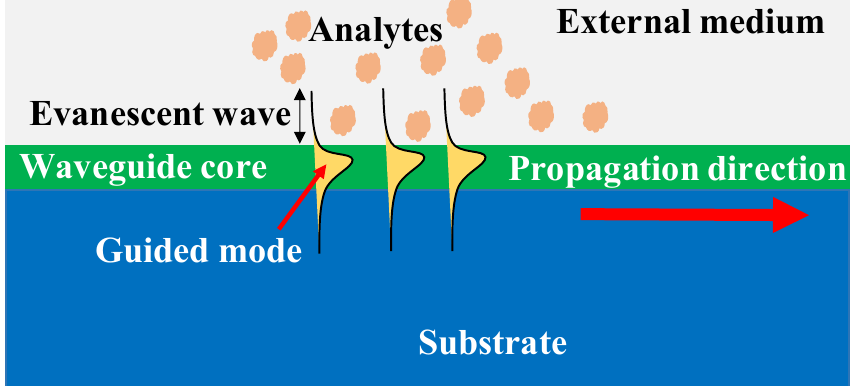
Figure 1. Illustration of evanescence field sensing.